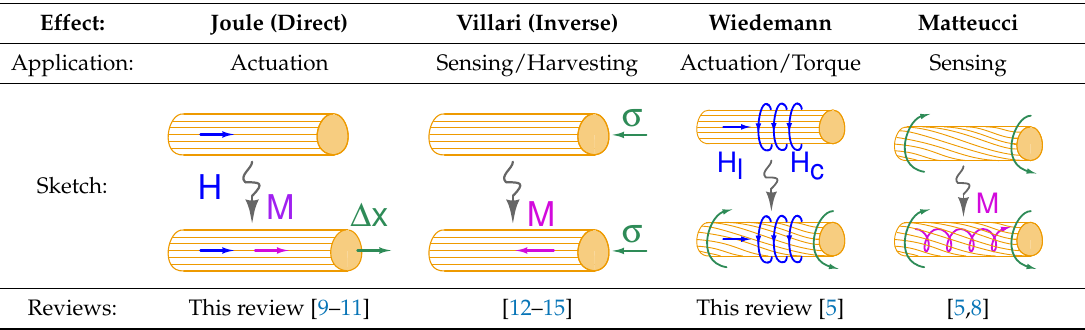
Table 1. The magnetostrictive effects with available reviews in the literature. The sketches are simplified for an immediate visualization. H is the magnetic field, M is the magnetization, ∆ x is the longitudinal deformation, σ is the longitudinal stress, H l and H c are a longitudinal and a circular magnetic field respectively, green arrows show an applied or induced